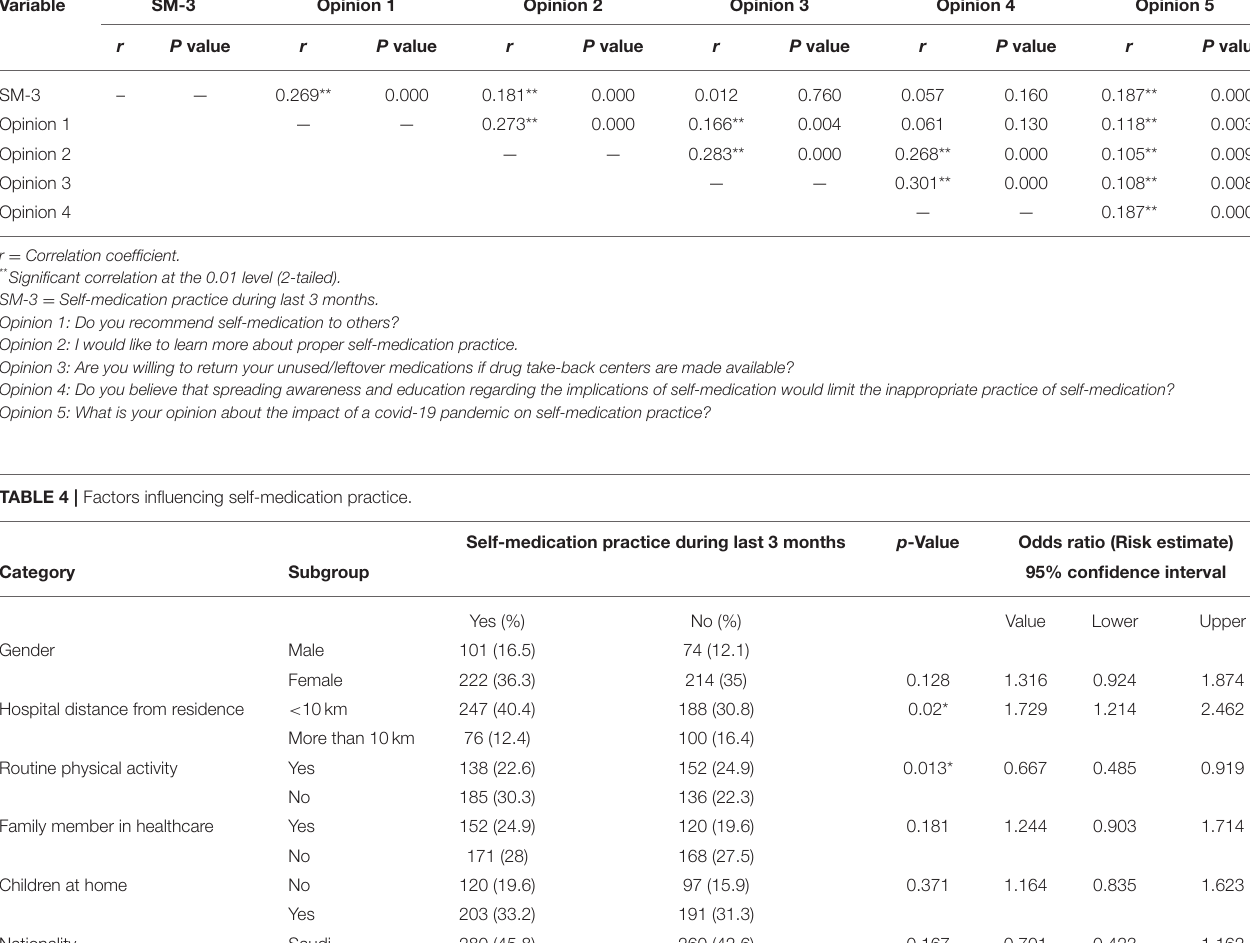
TABLE 3 | Pearson correlation between opinions with the SM practice. Variable